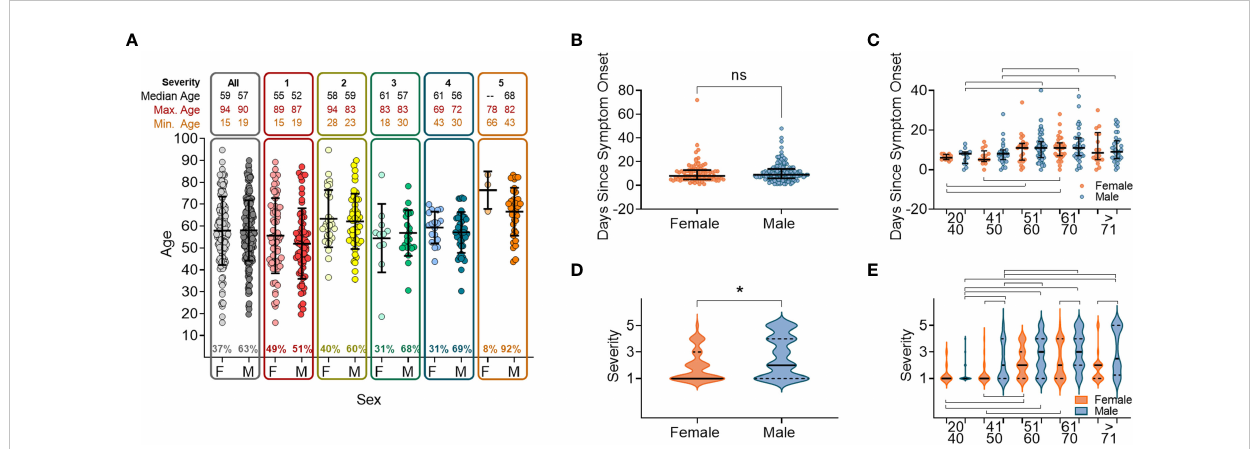
FIGURE 1 Sex and age distribution within groups with relation to days since disease onset and severity. (A) Number of individuals, female (F) or male (M), overall and when broken down into disease severity groupings (S1-S5). (B) Days since symptom onset split into females (orange) and males (orange) for all individuals. (C) Days since symptom onset split into females and males and relative to age groupings. (D) Disease severity split into females and males for all individuals. (E) Disease severity split into females and males relative to age groupings. In all panels mean values and con fi dence intervals shown (black lines). Lines above or below the groups indicate signi fi cant differences between groups as found by implementing a paired t-test or a non-parametric ANOVA (Kruskal-Wallis test). * indicates statistical signi fi cance P <